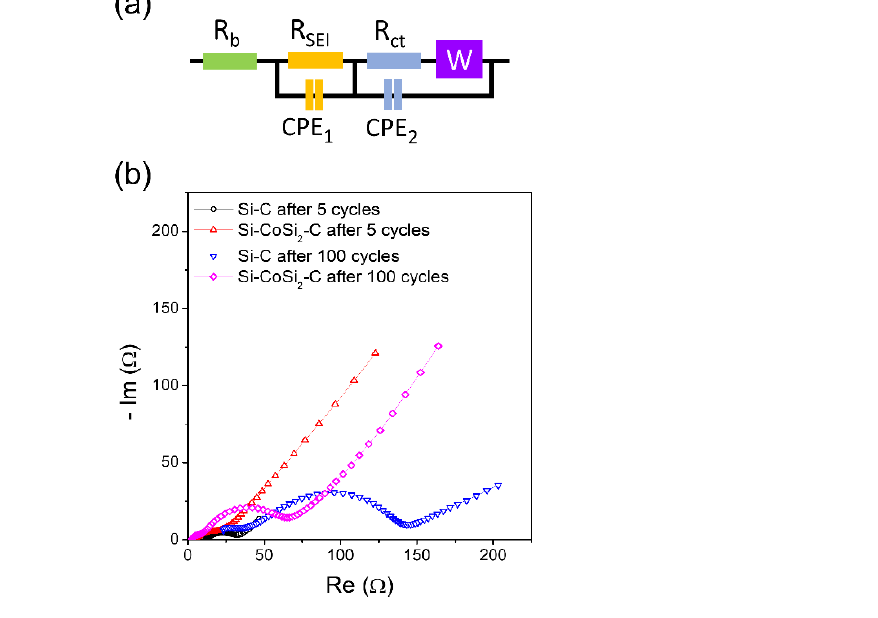
Figure 6. ( a ) Equivalent circuit model and ( b ) Nyquist plots of the Si-CoSi 2 -C and Si-C composite electrodes after 5 and 100 cycles.